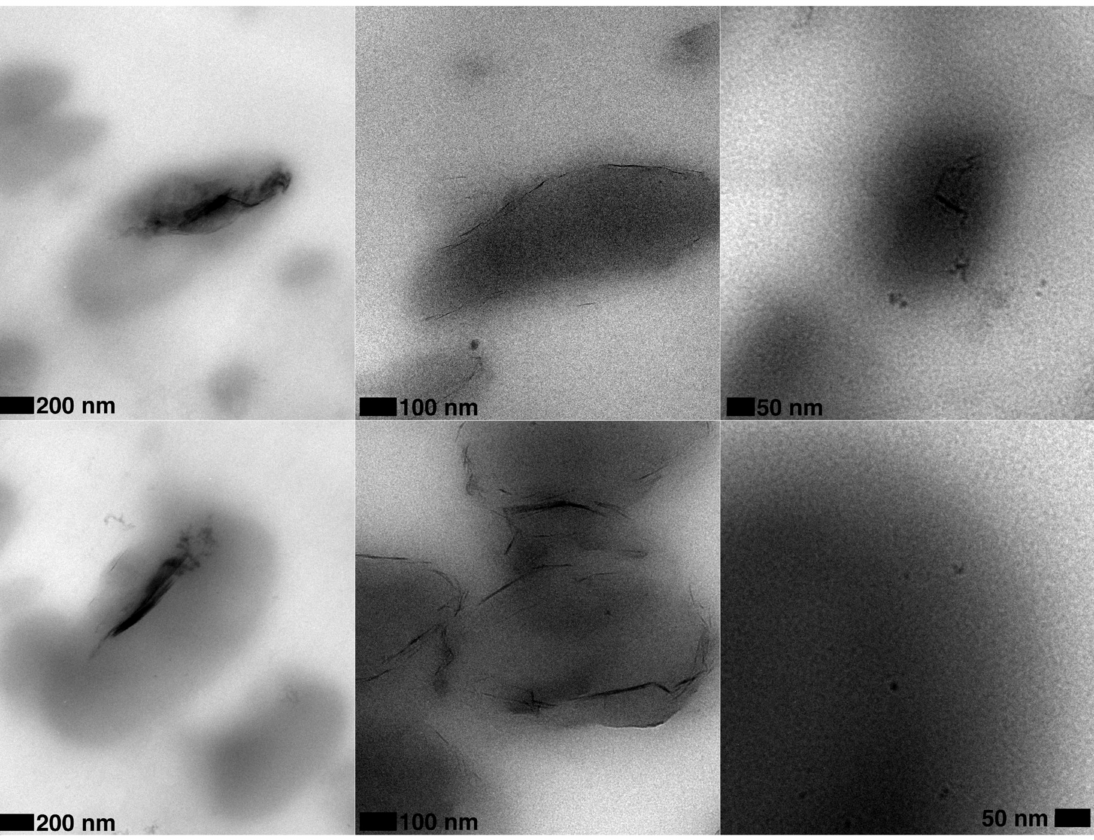
Figure 5. TEM micrographs of ( left ) SFD-MMT-CPLA-PBSA; ( middle ) C30B-CPLA-PBSA and ( right )